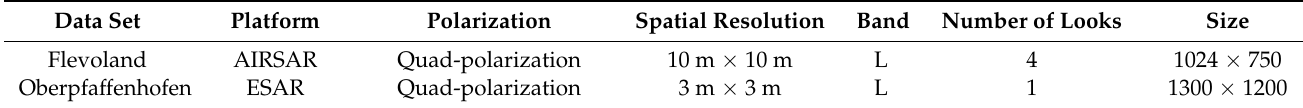
Table 1. Basic parameters of the dataset.